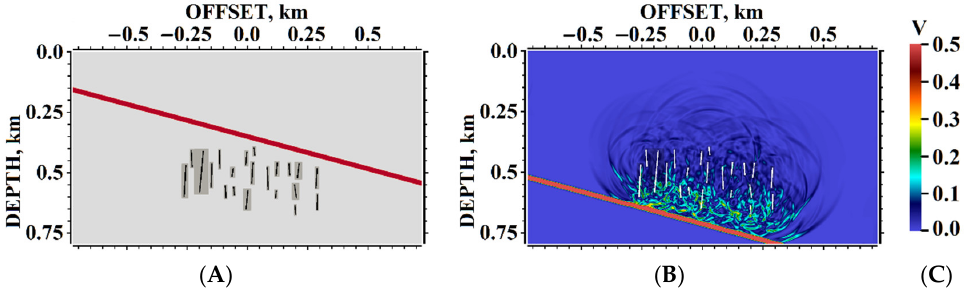
Figure 21. Example #1, incident P-wave: ( A ) geophysical model, overlapping curvilinear meshes, the incident P-wave is marked with the red line; ( B ) velocity modulus snapshot at the time moment 0.26 s; ( C ) scale of the velocity modulus used in the paper.